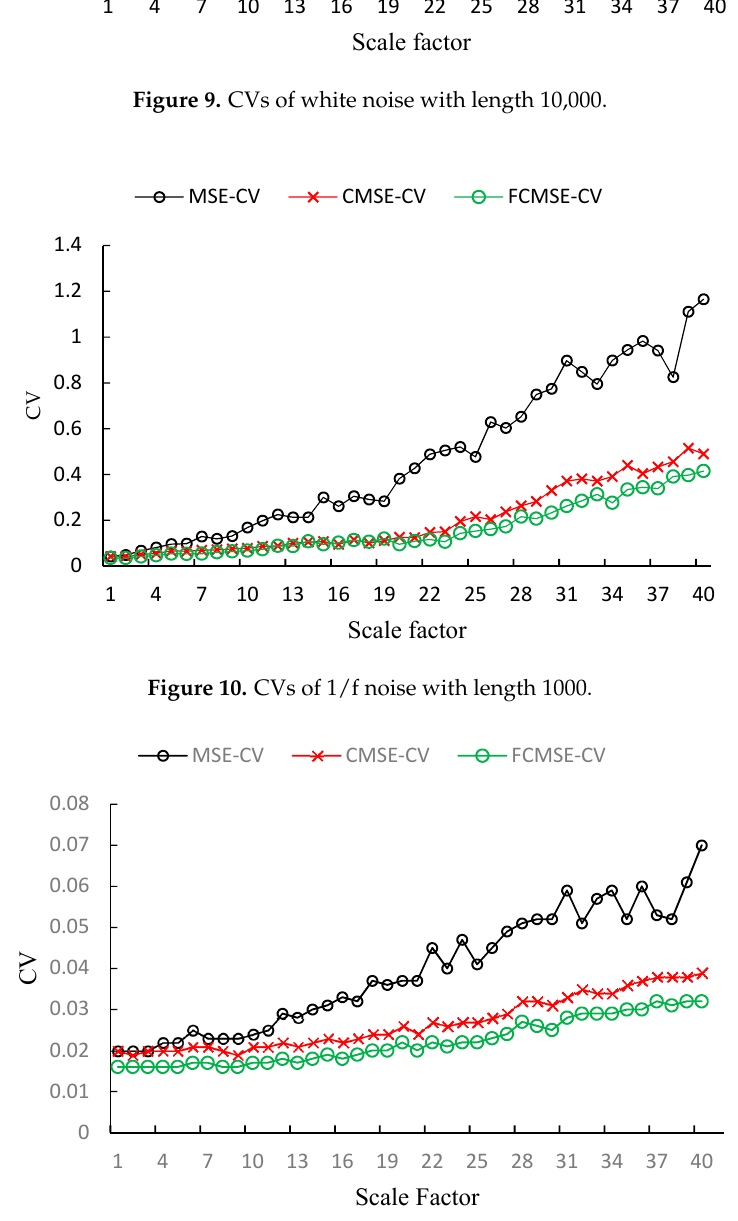
Figure 11. CVs of 1/f noise with length 10000.